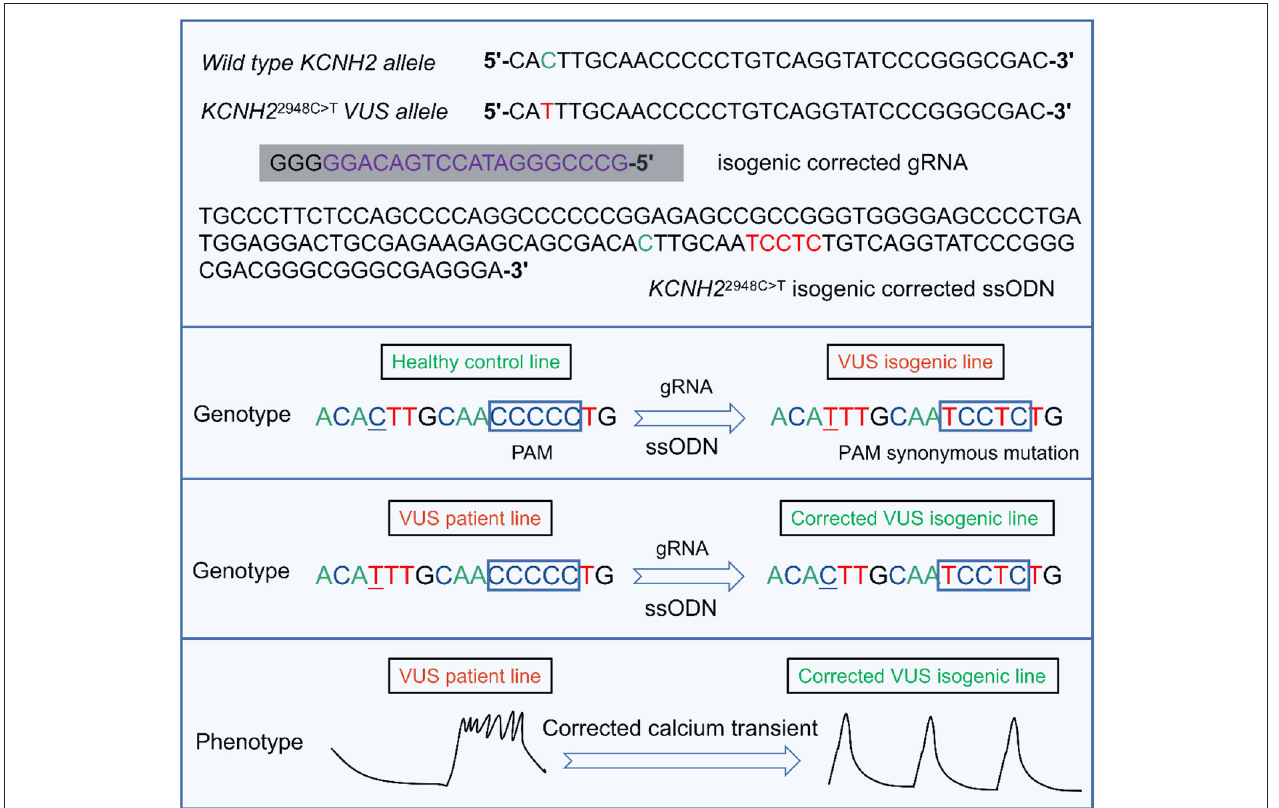
FIGURE 4 | A representative example of the targeted design of isogenic corrected gRNA or ssODN for the locus where KCNH2 2948C > T VUS is located, enabling correction of the point mutation ( 91). gRNA is designed by targeting the upstream of the 5’-NGG (PAM) of the KCNH2 VUS locus. By introducing ssODN containing homologous arms, the VUS isogenic line can be generated in a healthy control cell line. Similarly, the VUS line can also be corrected to enable a phenotype of abnormal calcium transient to be reversed. VUS, variants of uncertain significance. PAM, protospacer adjacent motif. gRNA, guide RNA. ssODN, single-stranded DNA